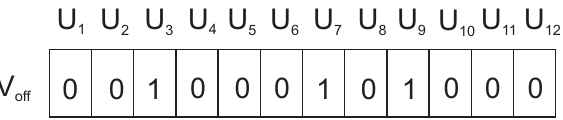
Figure 8. Offspring of the parent vectors shown in Figure